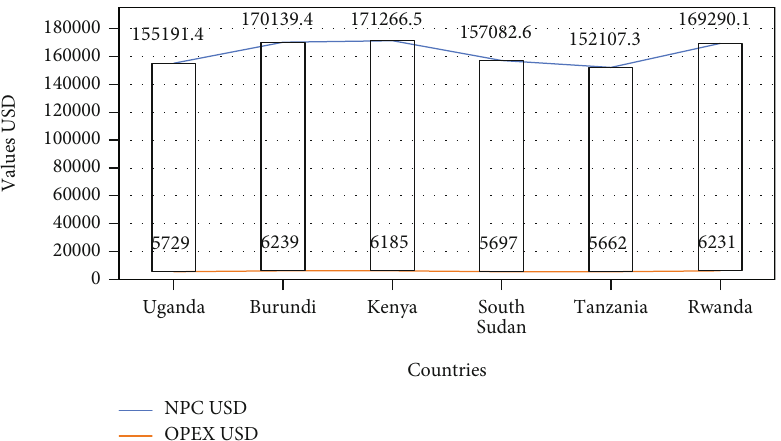
Figure 10: NPC and OPEX with the PV + storage technology.